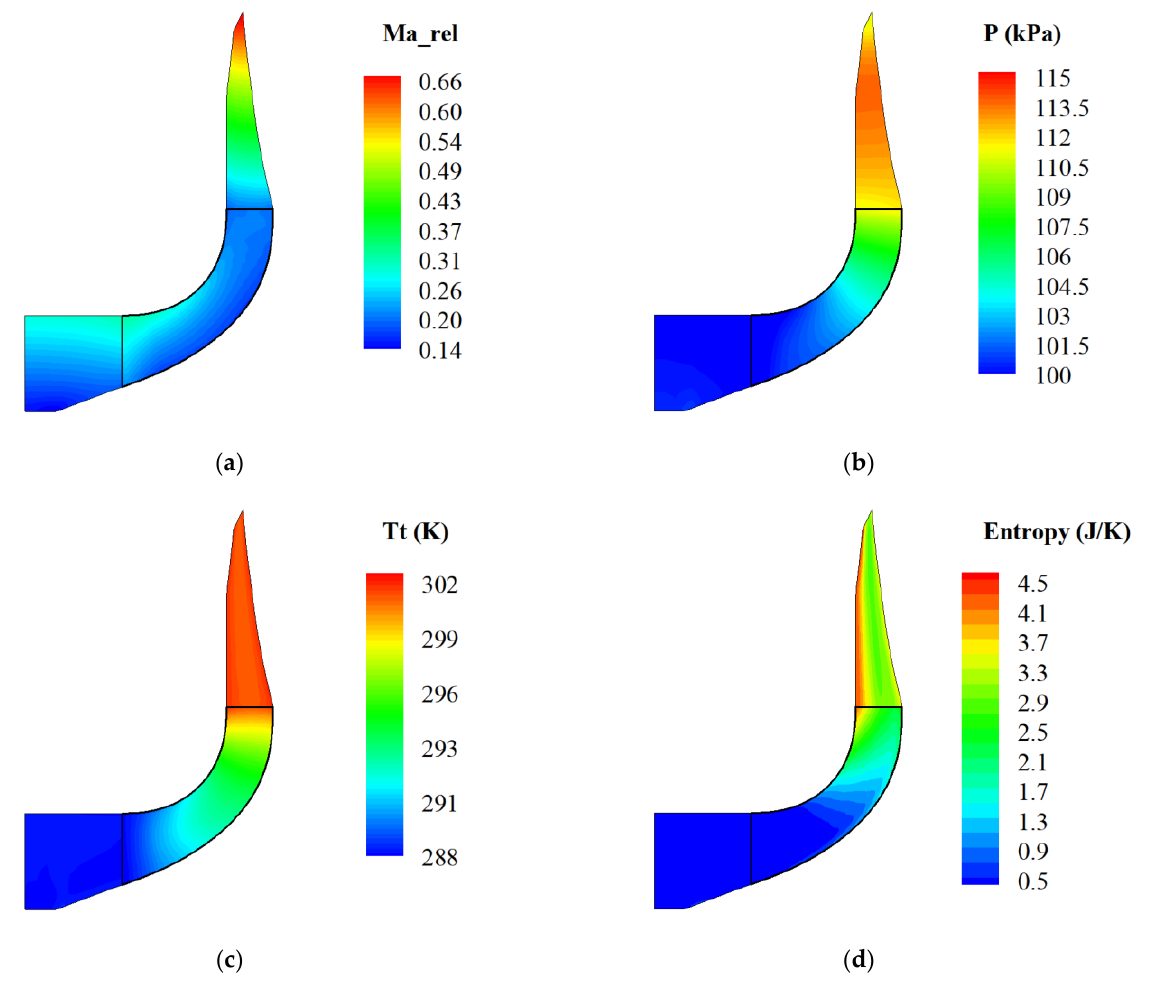
Figure 5. Meridional flow field of the LSCC at design mass flow rate: ( a ) Relative Mach number; ( b ) Static pressure; ( c ) Total temperature; ( d ) Entropy.